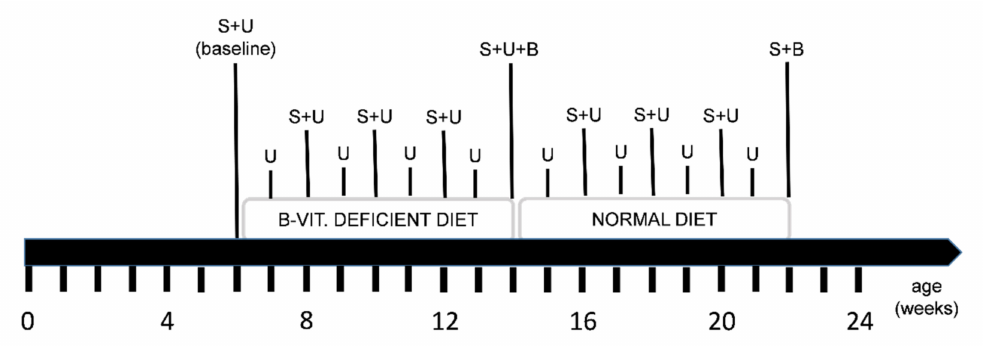
Figure 7. Time line of the study course, diet regimen and sampling points: S = serum sampling, U = 24-h urine sampling in metabolic cages, B = brain sampling: one half of the animals was euthanized in the middle (experimental week 9) and the other half at the end of the study (experimental week 17); feeding a diet deficient in vitamin B6, folate (B9) and B12 for 8 weeks was followed by a normal diet period for another 8